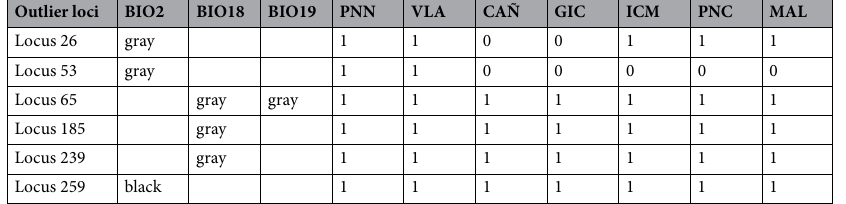
Table 2. Distribution of highly significant outlier loci in collected sites, correlated with environmental variables (Confidence level, gray = 95%; black = 99%). 0 = Locus absent; 1 = Locus present